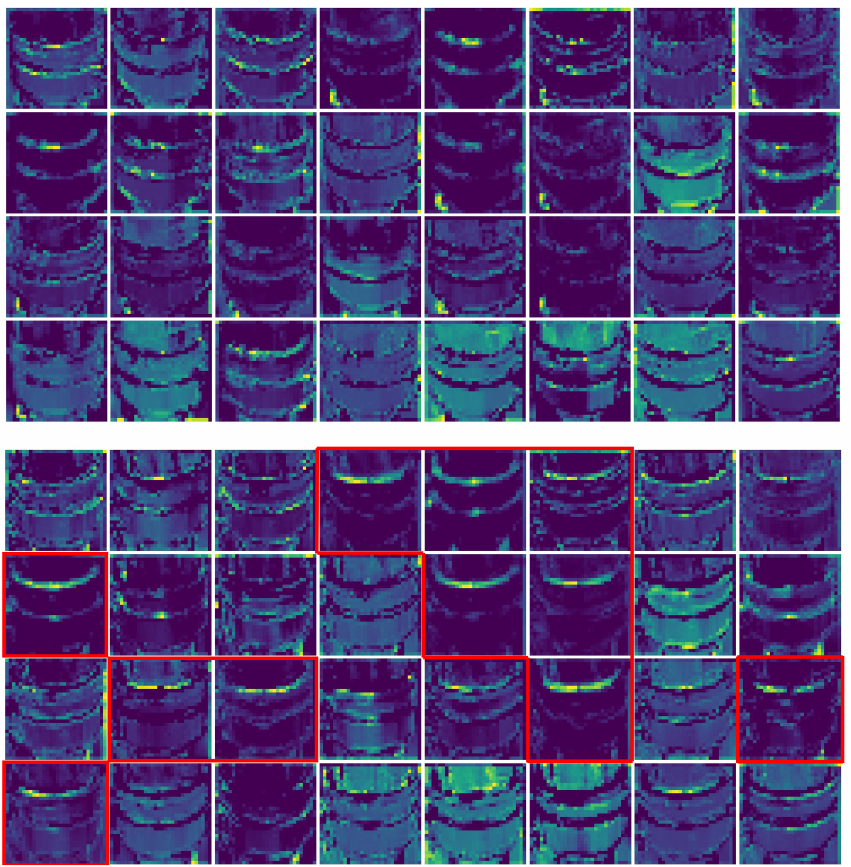
Figure 8. The 32 channels of the third convolutional layer activation on both a normally functioning AirTender ( above ) and a faulty AirTender ( below ). In the image below, red contours highlight the feature maps related to the filters which mainly react to the presence of spilled oil on the surface of AirTender core. The same filters are not activated on a similar image of AirTender with no spilled oil, as shown in the upper